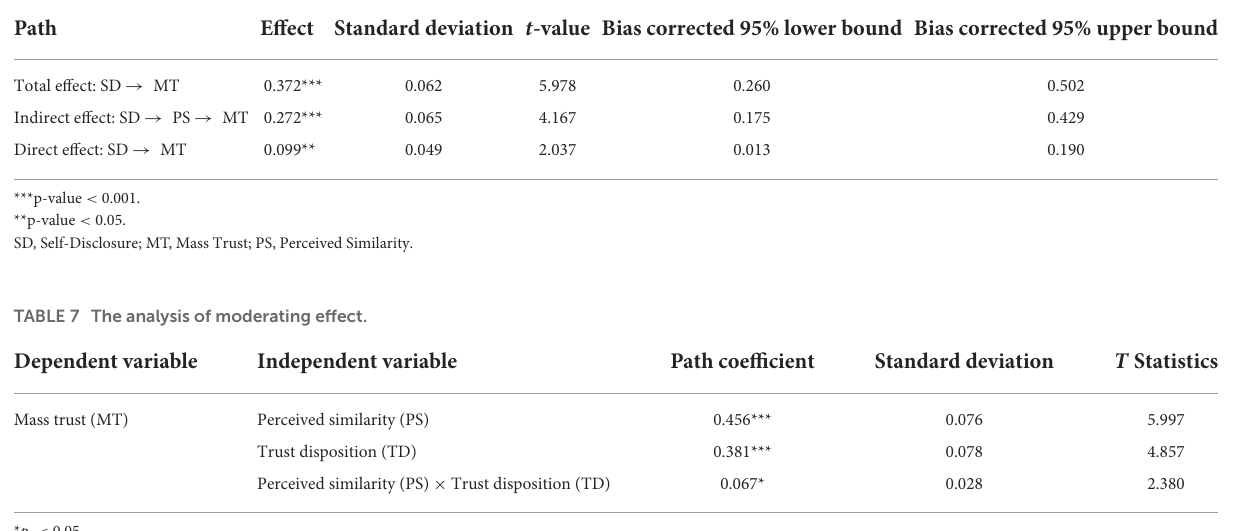
TABLE 6 Mediation